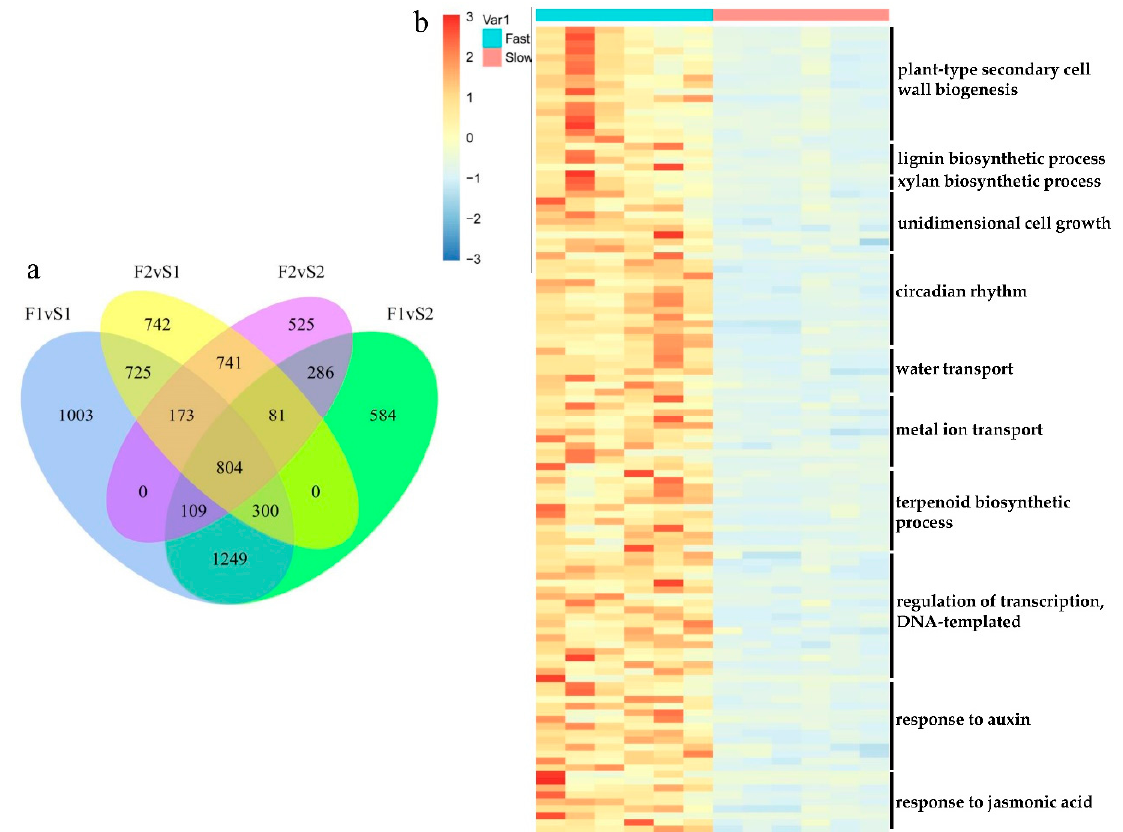
Figure 3. ( a ) The Venn analysis result of upregulated genes for fast-growing samples compared with slow-growing samples. There were 804 common up-regulated genes for fast samples compared with slow samples. Samples of Fast1 vs. Slow1 and Fast2 vs. Slow1 (F2vS1) had a relatively large number of characteristic up-regulated genes. ( b ) Expression patterns of 118 differentially expressed genes (DEGs) enriched in the key gene ontology (GO) biological processes (BPs).